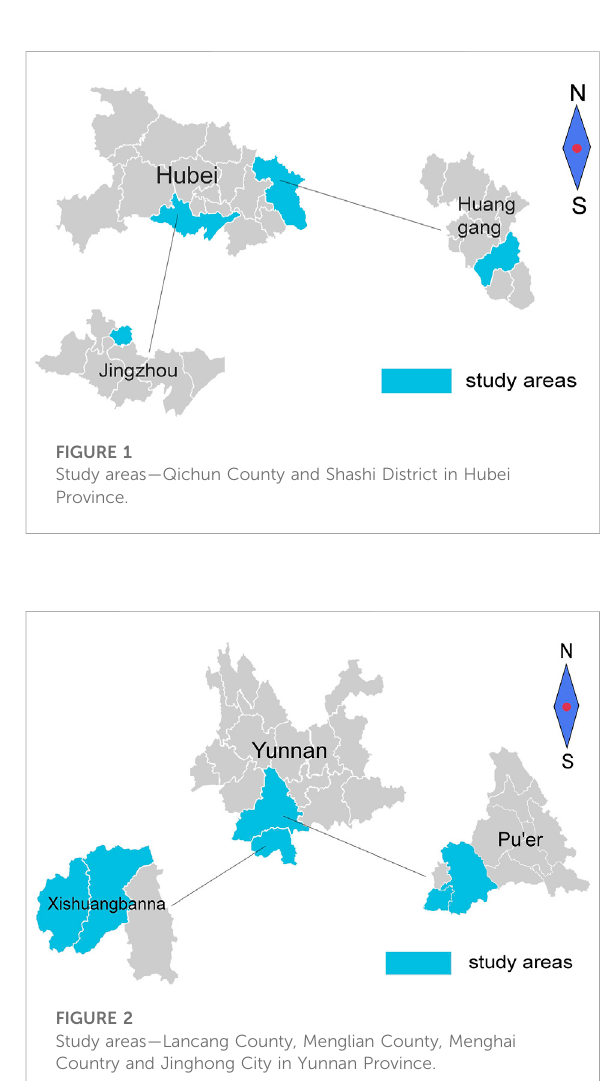
FIGURE 2 Study areas — Lancang County, Menglian County, Menghai Country and Jinghong City in Yunnan